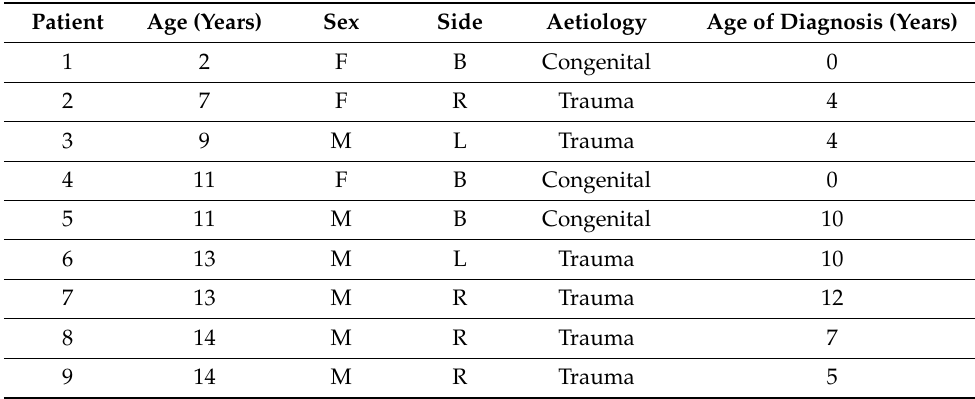
Table 1. Characteristics of the patient group depending on the age of the patient and age at which ankylosis was diagnosed. Side: B—bilateral, R—right-sided, L—left-sided. Patient Age (Years) Sex Side Aetiology Age of Diagnosis (Years) 1 2 F B Congenital 0 2 7 F R Trauma 4 3 9 M L Trauma 4 Congenital 0 5 11 M B Congenital 10 6 13 M L Trauma 10 M